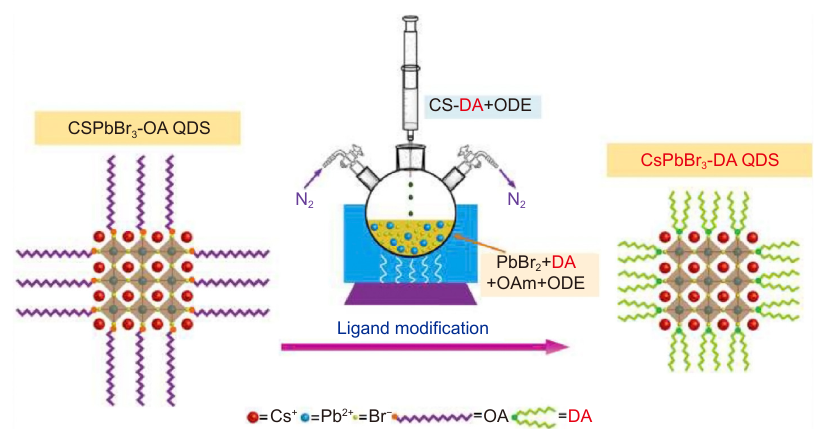
Fig. 1 | The schematic illustration of the surface in the CsPbBr 3 QDs with ligand modification